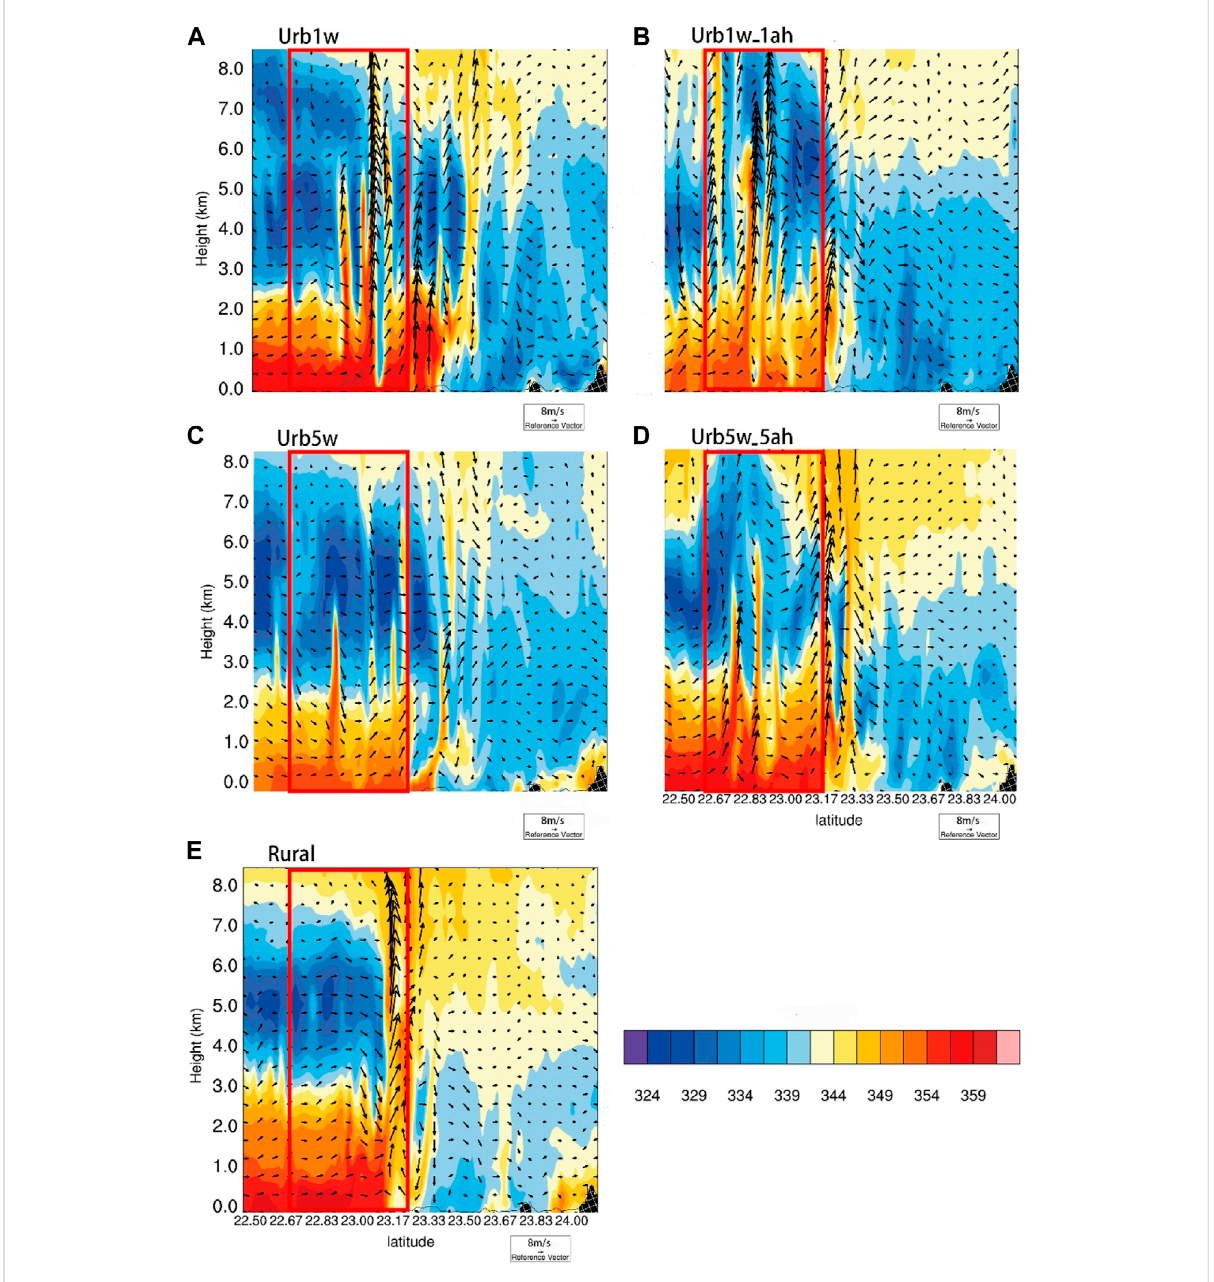
FIGURE 11 As in Figure 10 except for the wind and pseudo-relative potential